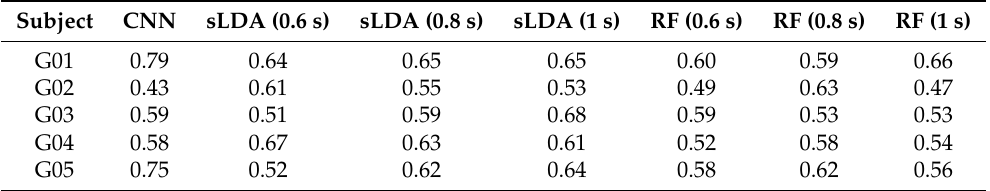
Table A3. Comparison of classification performance (in terms of precision) in validation from Dataset 2